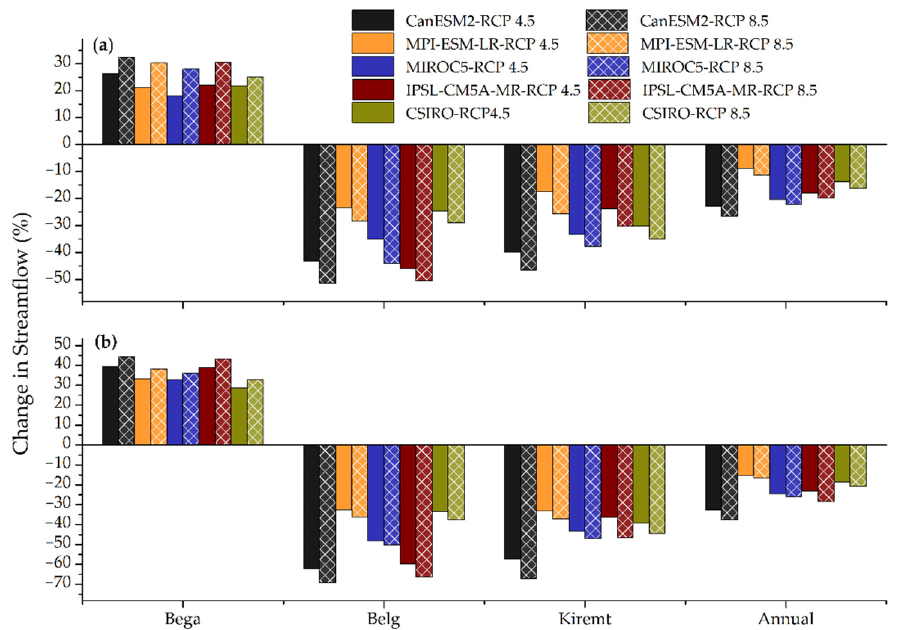
Figure 16. Percentage changes of annual and seasonal streamflow with reference to the baseline: ( a ) near future period from 2021–2050; and ( b ) far future period from 2071–2100. In the far future, CanESM2 under RCP8.5 projected the most significant seasonal decreases to occur in the Belg (69.1%) and Kiremt (67.0%) seasons. An estimated minimum seasonal decrease of 23.5% in the Belg and 17.5% in the Kiremt was obtained with MPI- ESM-LR under RCP4.5. In contrast, CanESM2-RCP8.5 gave the highest projected